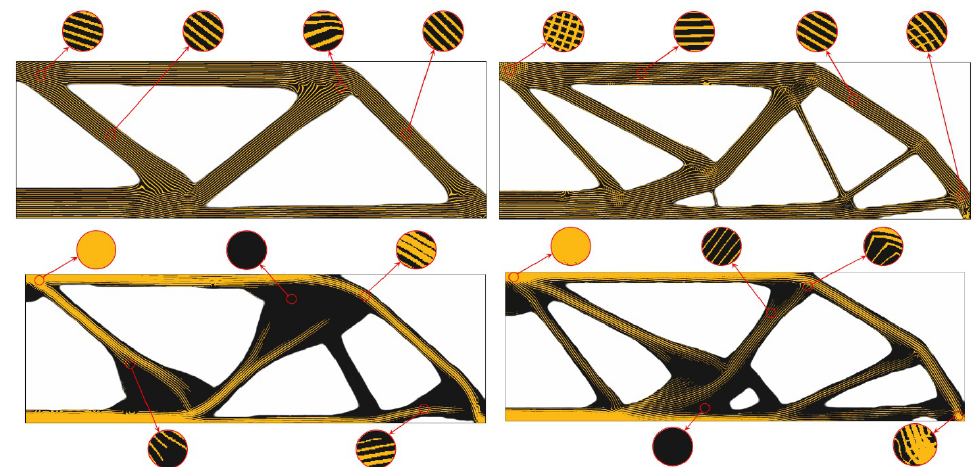
Figure 6. MBB—post-processed design result of FRC structure with fixed ( top-row ) and varying fiber volume fraction ( bottom-row ) using a micro-structure unit cell with rectangular-shape ( left-column ) and cross-shaped ( right-column ) fiber layout. The black color represents matrix material, and the yellow colored part is fiber material